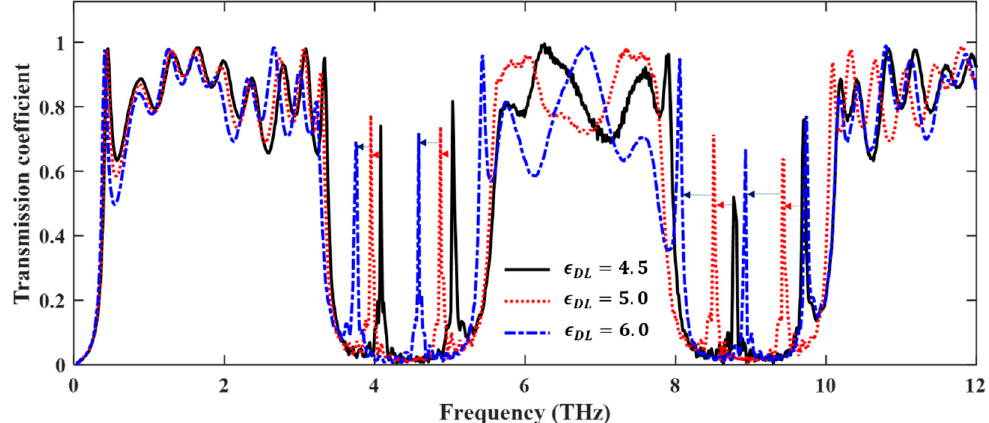
Figure 11. Comparison of the transmission curves and defect modes of 1D plasma PhCs with differ- ent defect layer permeabilities ε DL = 4.5, 5.0, and 6.0. The plasma has the properties of ω p = 2.0 THz, ϑ c = 50 GHz.